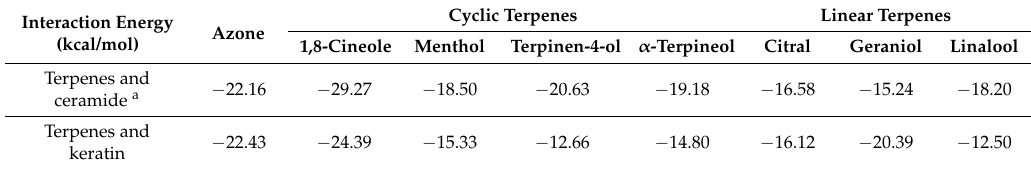
Table 4. Interaction energy of formation of terpene-ceramide/keratin complexes.